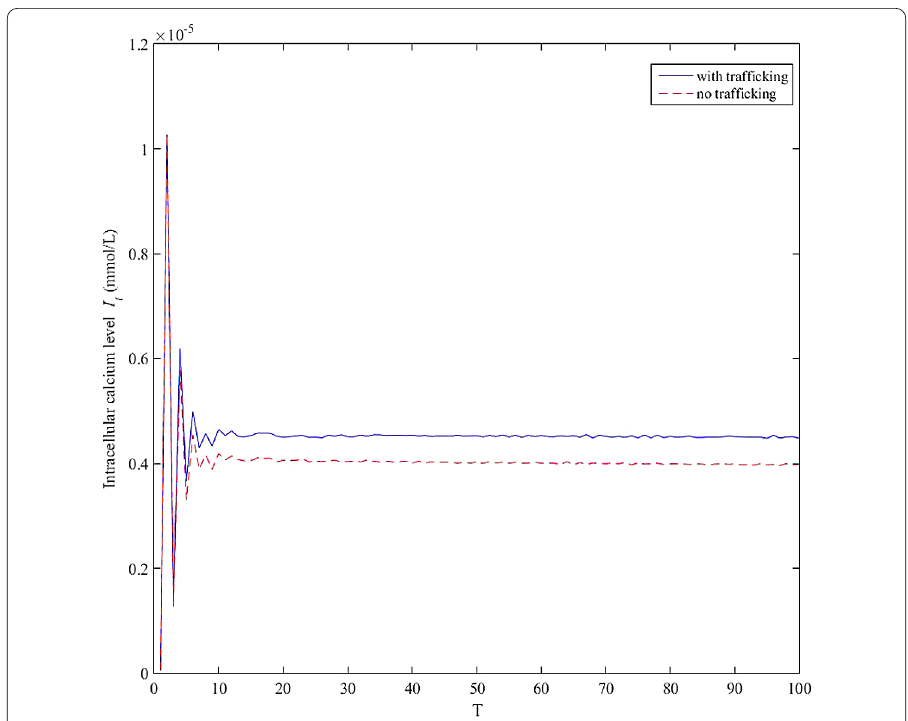
Figure 4 Simulated time courses of cytosolic calcium concentration above its equilibrium level I b = 2.4 × 10 –4 mmol/L, using the parameter values given in Tables 1 and